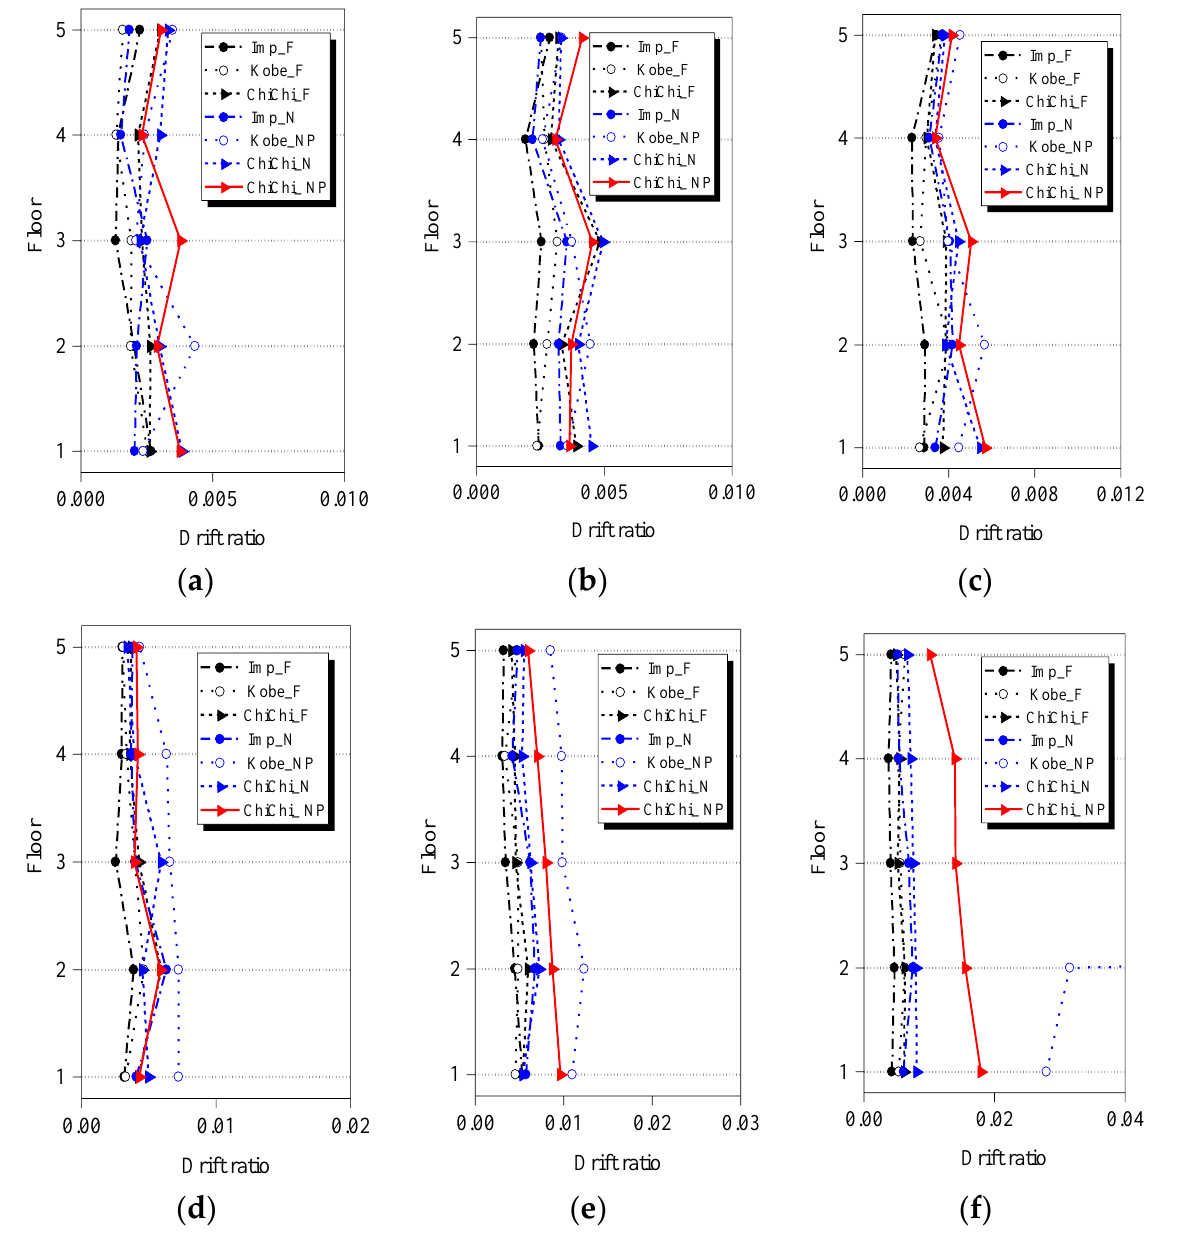
Figure 8. Maximum inter-story drifts of the superstructure: ( a ) PGA of 0.10 g; ( b ) PGA of 0.20 g; ( c ) PGA of 0.30 g; ( d ) PGA of 0.40 g; ( e ) PGA of 0.60 g; ( f ) PGA of 0.80 g.